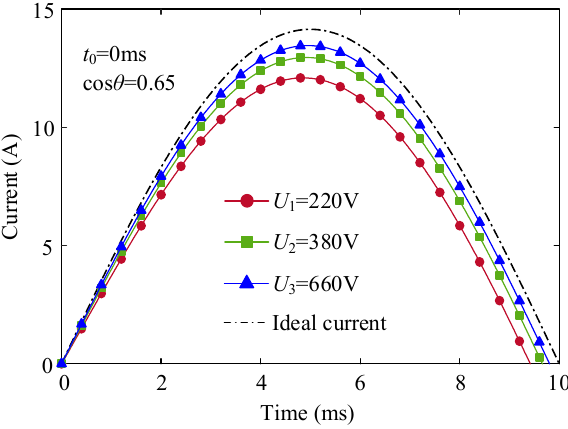
Figure 5. Arc current waveform under different supply voltages.